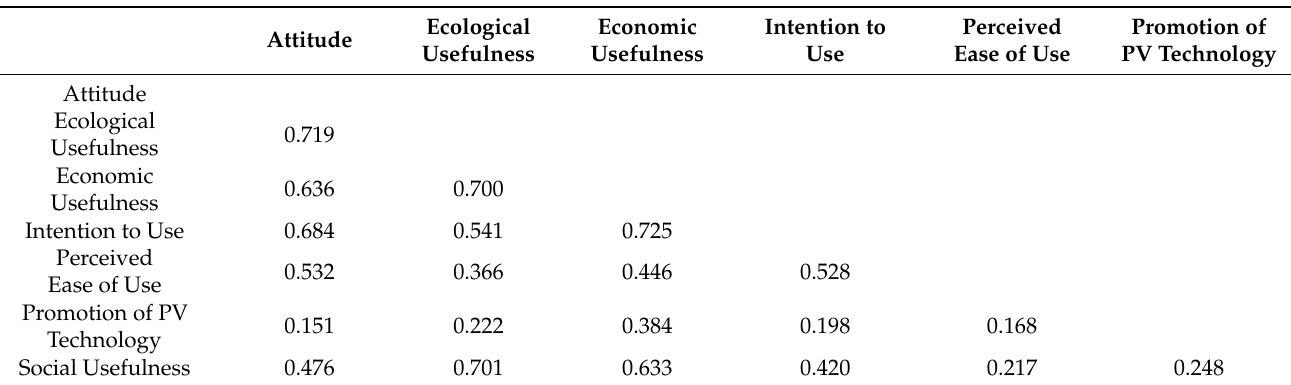
Table 4. Heterotrait–Monotrait (HTMT).